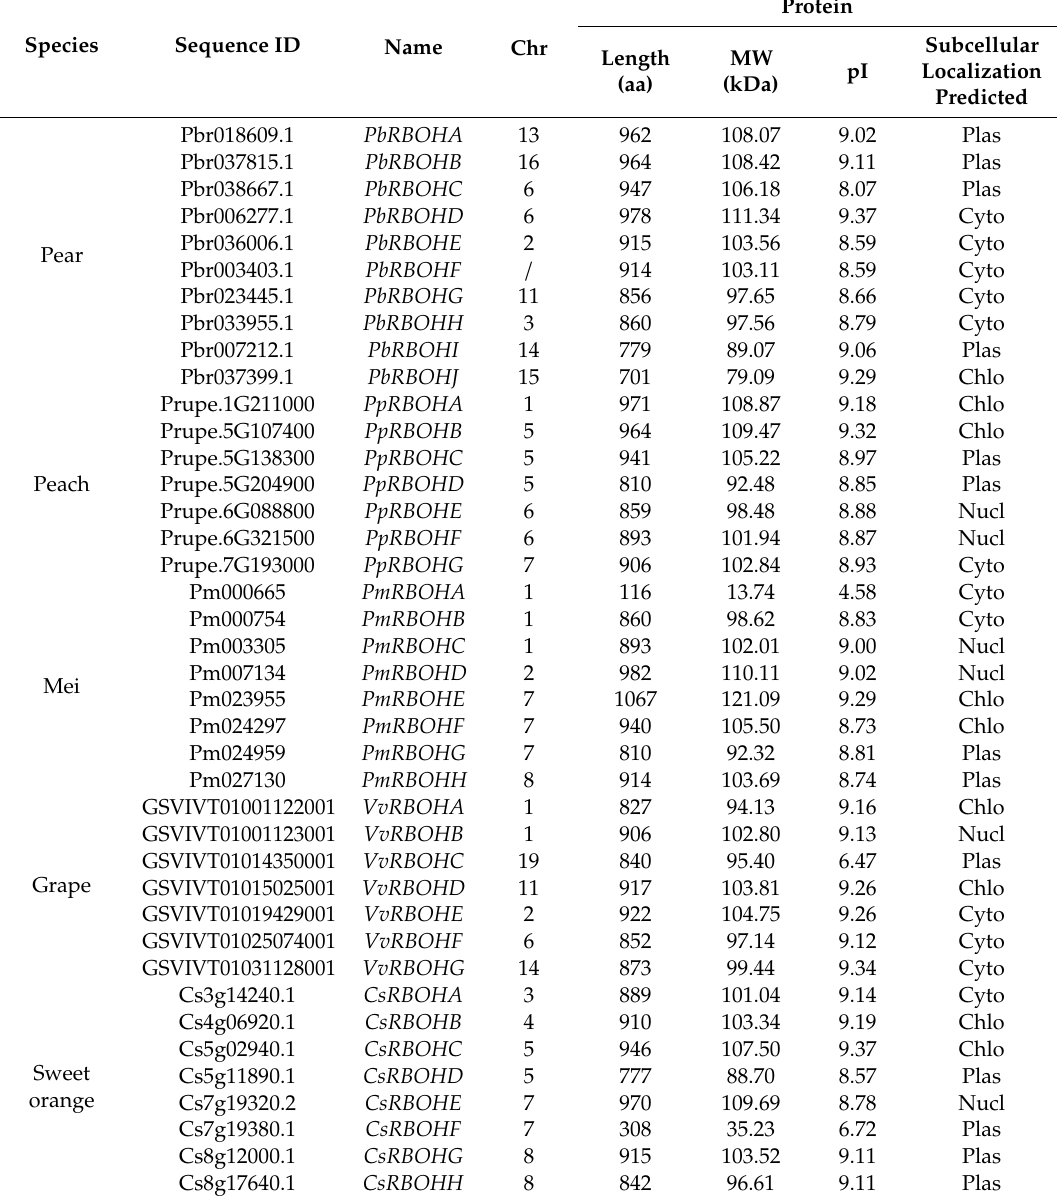
Table 1. Sequence information of the RBOH family genes of five fruit-producing